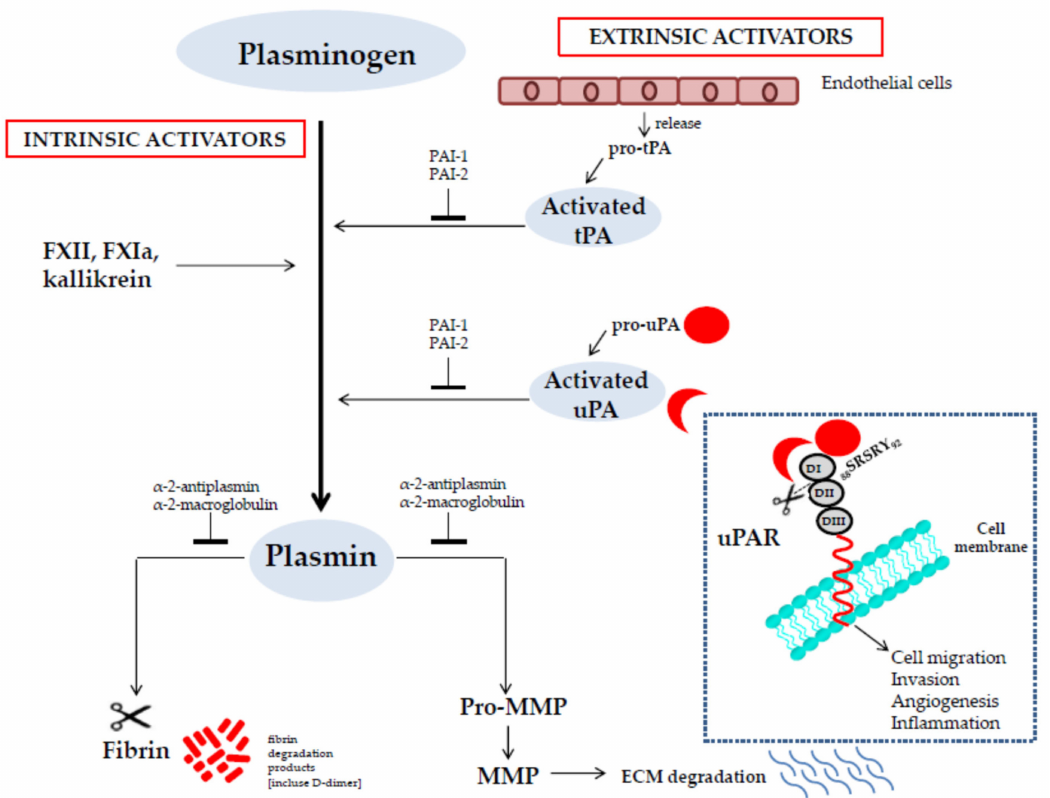
Figure 1. Schematic representation of the plasminogen activation